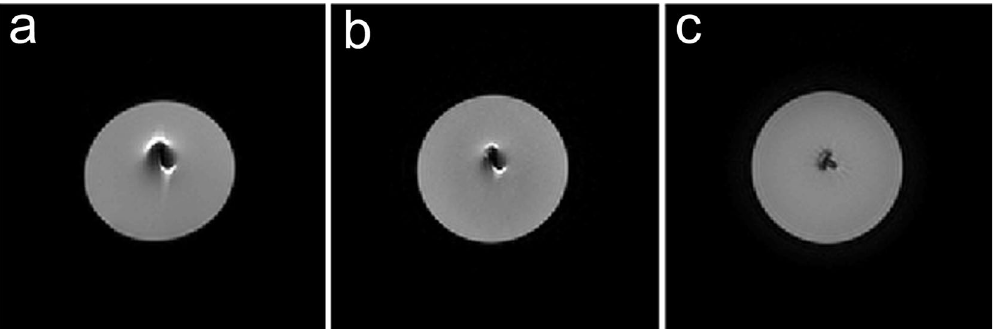
Figure 1. Images of an aneurysm clip embedded in agarose gel obtained by three DWI sequences. Image distortion around the clip is the largest in SS-EPI DWI ( a ), second largest in RESOLVE DWI ( b ), and the minimal in TGSE-BLADE DWI ( c ). Note the distorted contour of agarose gel in SS-EPI DWI and RESOLVE DWI.